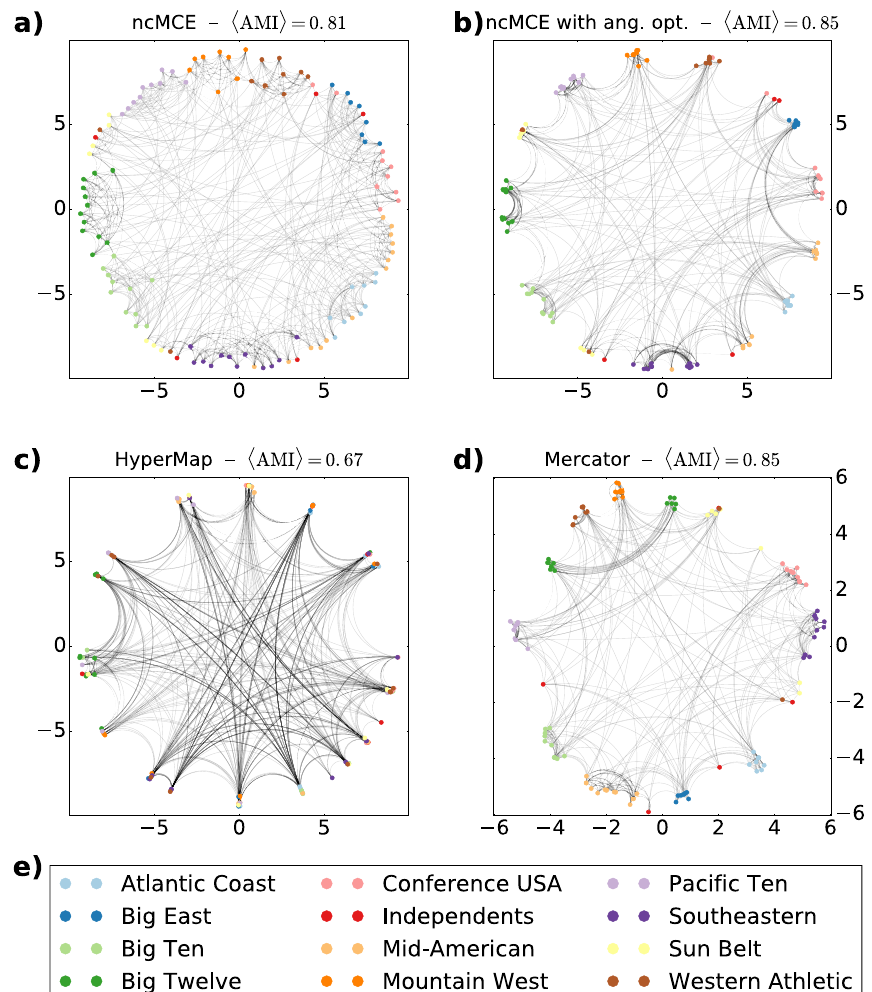
Figure 6. The layouts of the American College Football web on the native hyperbolic disk that reached the highest greedy routing scores. ( a ) The layout based on the coordinates resulted from the original ncMCE method. ( b ) The layout according to the coordinates obtained with our approach, optimising the results of ncMCE. ( c ) The hyperbolic layout obtained with HyperMap. ( d ) The embedding according to Mercator. The colour of the nodes indicates the team conference as listed in panel ( e ). The title of panels ( a – d ) include the average adjusted mutual information between the communities found by Louvain over 10 runs and the original team